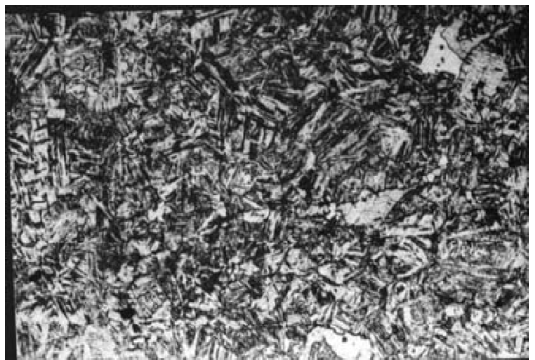
Fig. 6. Microstructure of aging samples at 550 o C for 1 hour (200X).